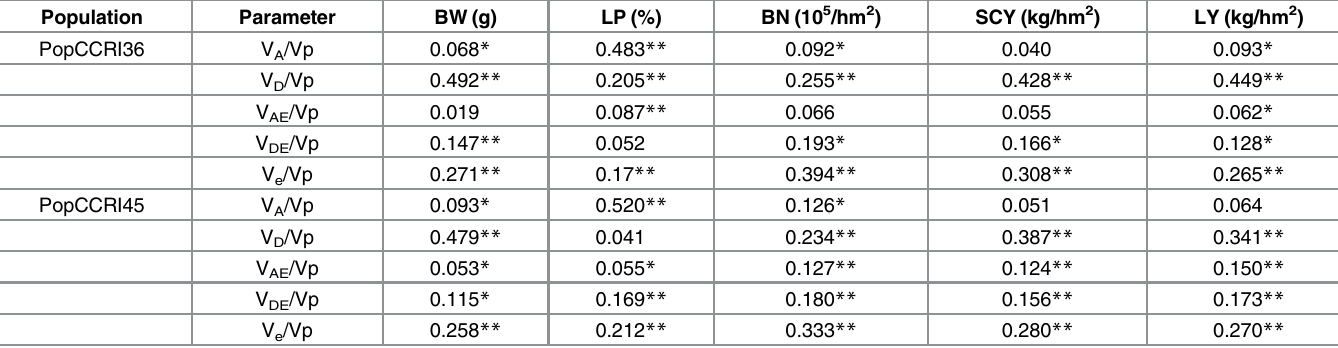
Table 2. Estimated ratios of variance components to phenotypic